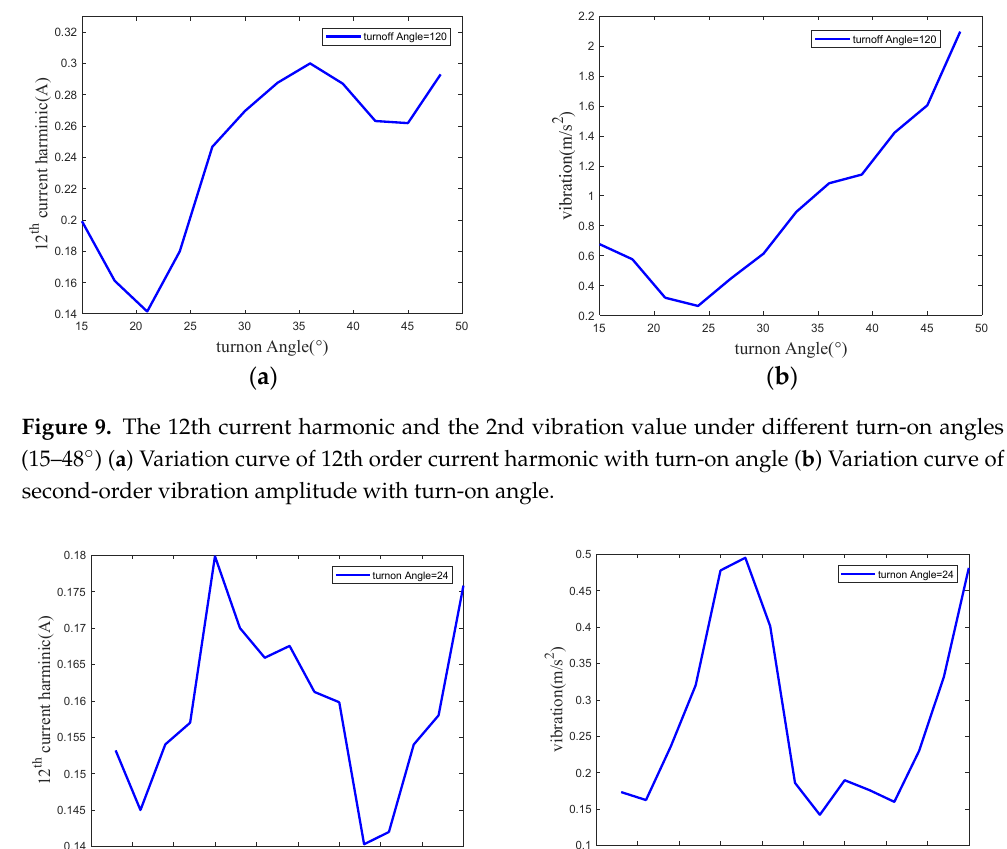
Figure 10. The 12th current harmonic and the 2nd vibration value under different turn-off angles (108–150°) and fixed turn-on angle (24°) ( a ) Variation curve of 12th order current harmonic with turn-on angle ( b ) Variation curve of second-order vibration amplitude with turn-on angle.